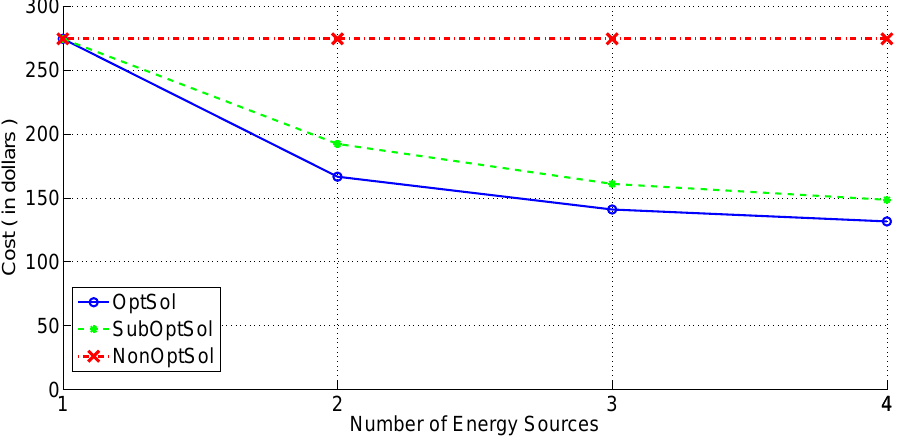
Figure 4. Sum Cost Minimization versus Number of Energy Sources.